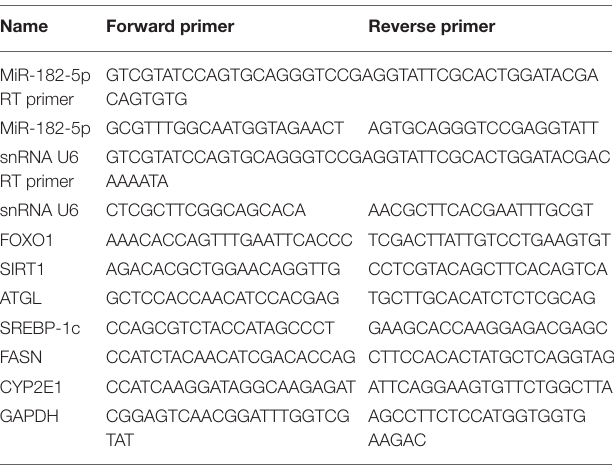
TABLE 1 | Primer sequences of miRNA and mRNA used in the present